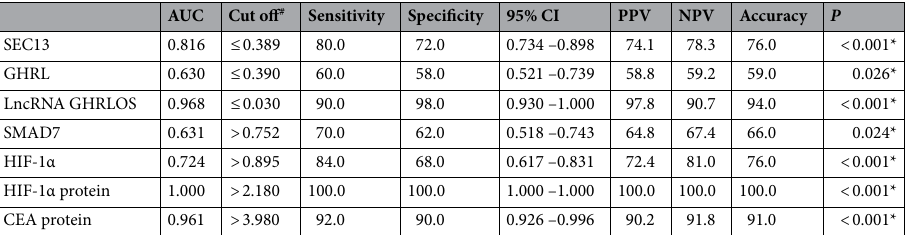
Table 5. Diagnostic accuracy of SEC13, GHRL, lncRNA GHRLOS, SMAD7, HIF-1α genes expression, serum HIF-1α and CEA levels. CI: Confidence intervals, AUC: area under the curve, PPV: positive predictive value, NPV: negative predictive value. *Statistically significant at P ≤ 0.05. # Cut off was choose according to Youden